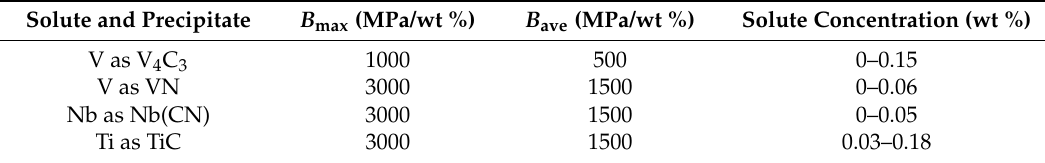
Table 3. Coefficient ( B ) of precipitation strengthening, from